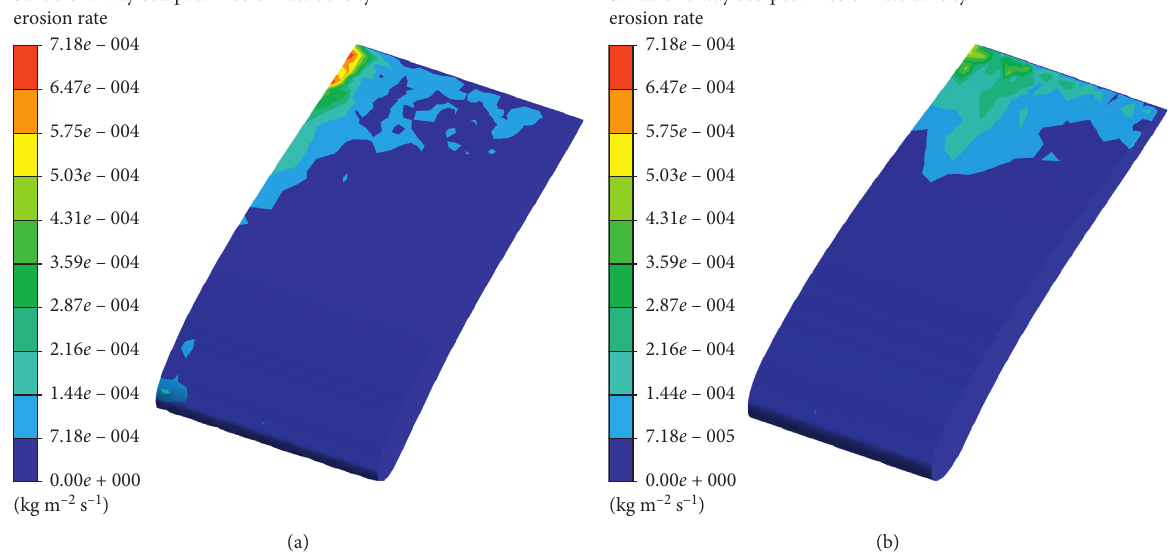
Figure 12: Comparison of erosion rate after optimization. (a) Optimized. (b) Original prototype.